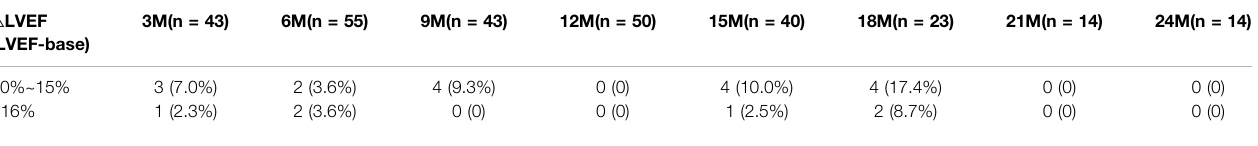
TABLE 2 | Changes in left ventricular ejection fraction are divided into two groups, and the number of cases is